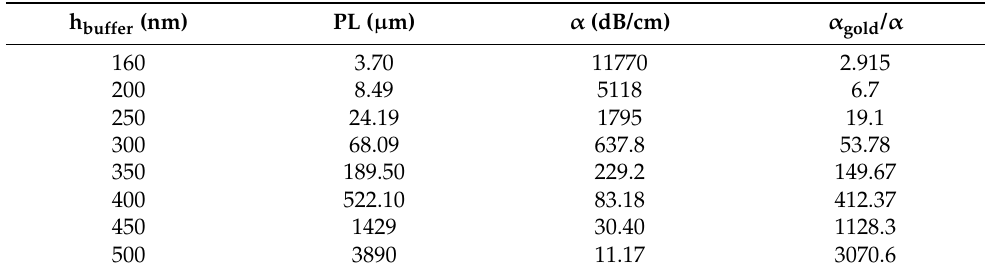
Table 3. The propagation length and the propagation loss for h buffer variation.